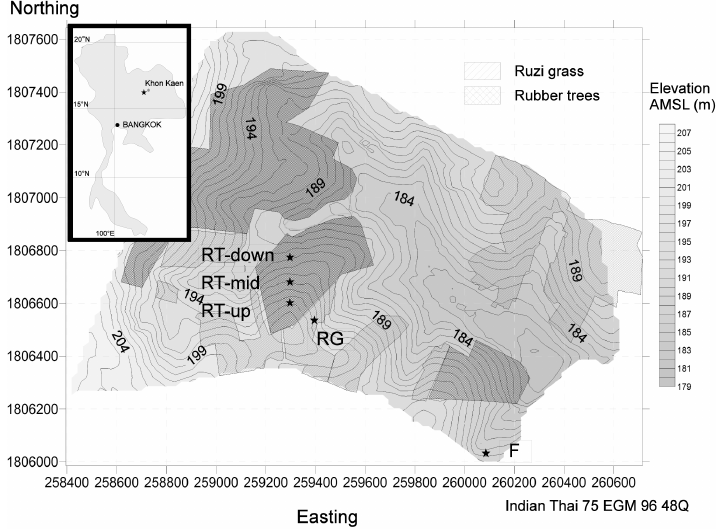
Figure 1. Location of the experimental watershed with the different different land uses and measurement sites; F: forest, RG: ruzi grass, RT-up: rubber tree upslope, RT-mid: rubber tree midslope, RT-down: rubber tree downslope, and location of meteorological station MS.